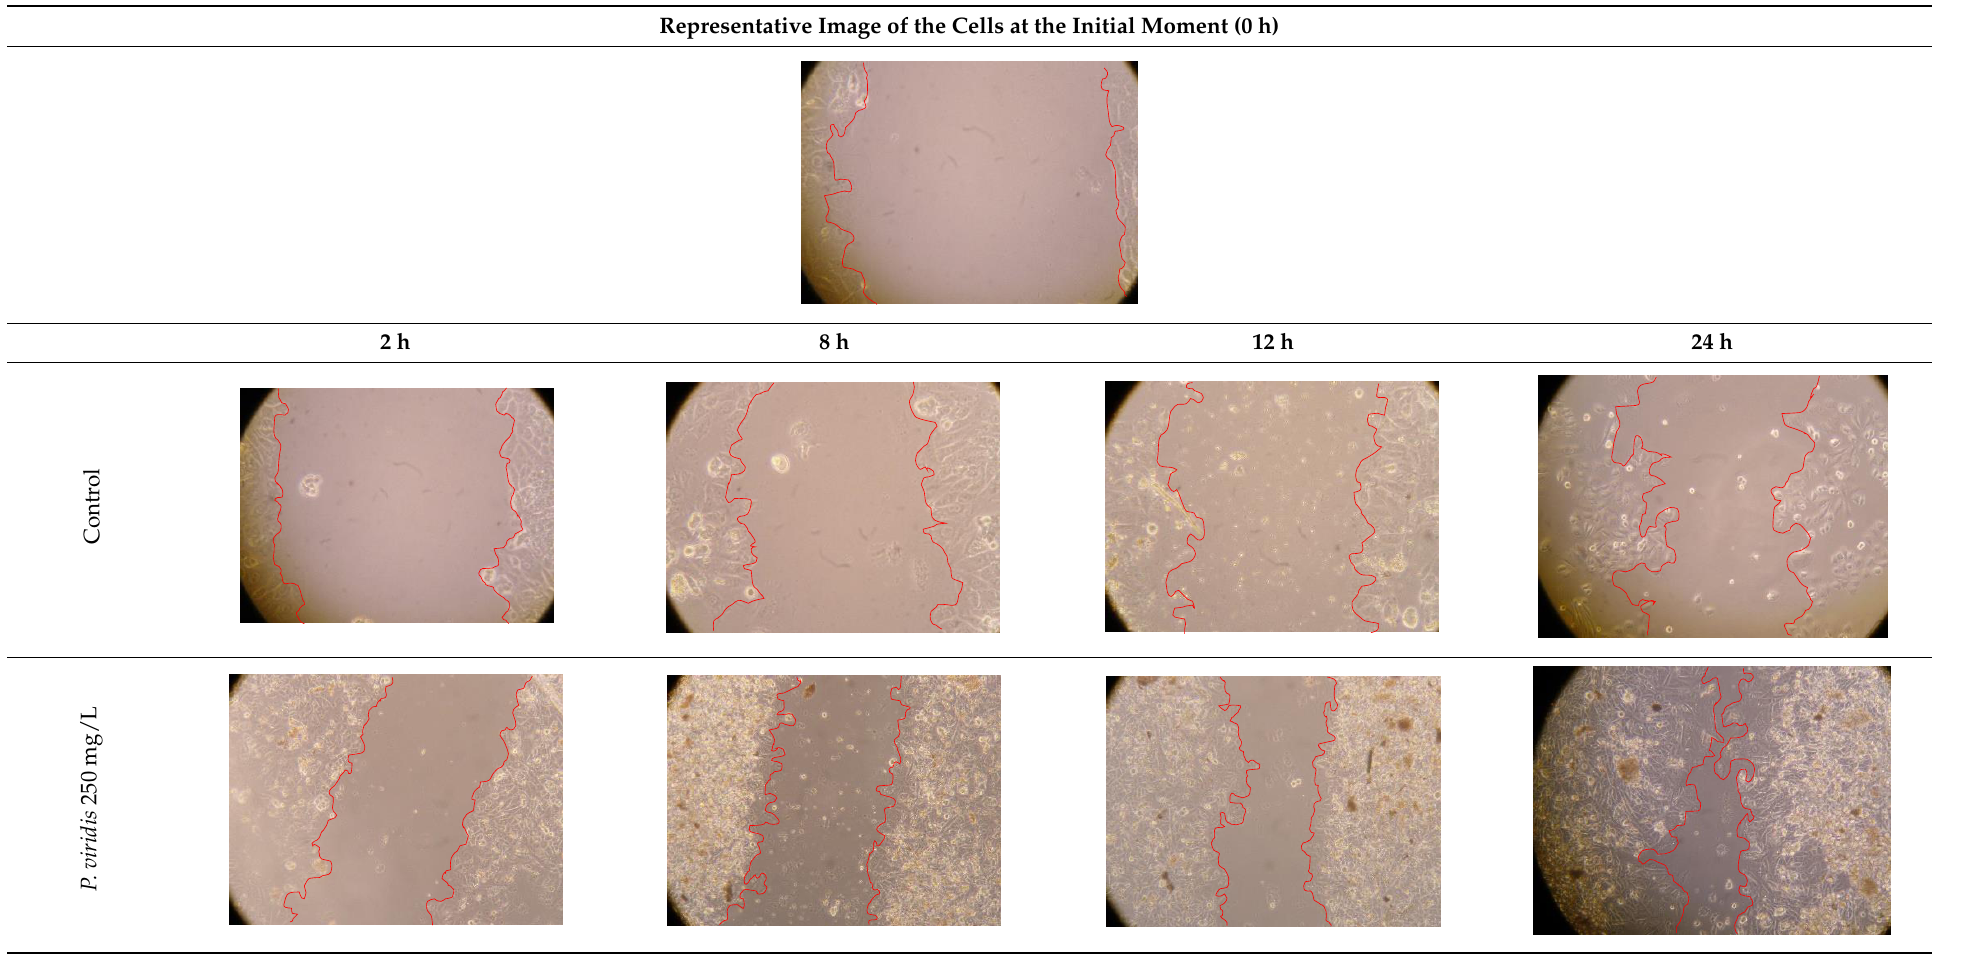
Table 1. Microscopic images obtained from the scratch wound-healing assay with the samples of ayahuasca (magnification: 100×). The margins of the scratch appear in red.